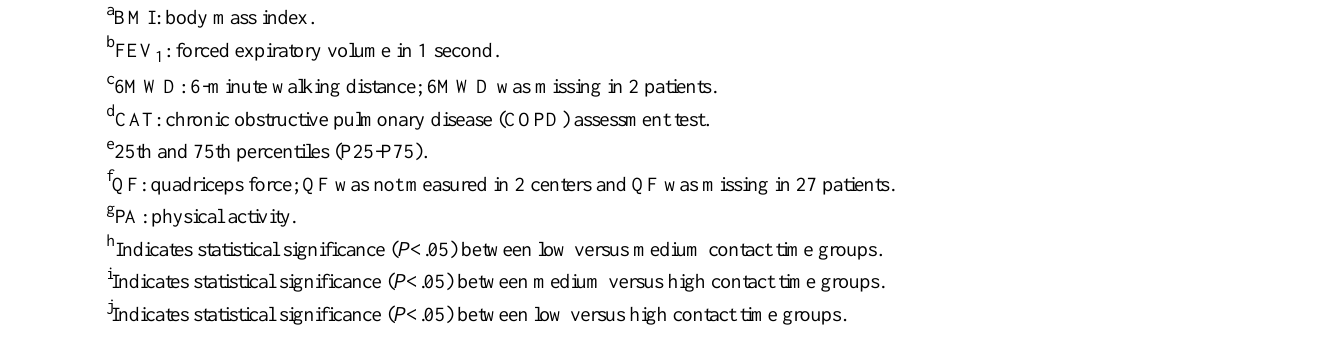
Figure 5. Change in physical activity (PA; mean [SE]) across groups of patients according to total contact time; adjusted for age, baseline functional exercise capacity, baseline forced expiratory volume in 1 second, baseline symptom score and number of acute exacerbations in the previous 12 months. P value (P for trend) indicates difference in intervention effect between patients divided based on total contact time, after adjusting for the covariates. Data are based on Actigraph measurements and include 140 patients. Unadjusted scores were mean(SD) +1489 (SD 2310) steps per day, +907 (SD 2306) steps per day and +193 (SD 2375) steps per day in low, medium and high contact time groups,